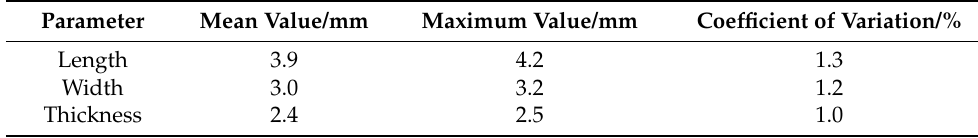
Table 1. Three axis sizes of industrial hemp seed. Parameter